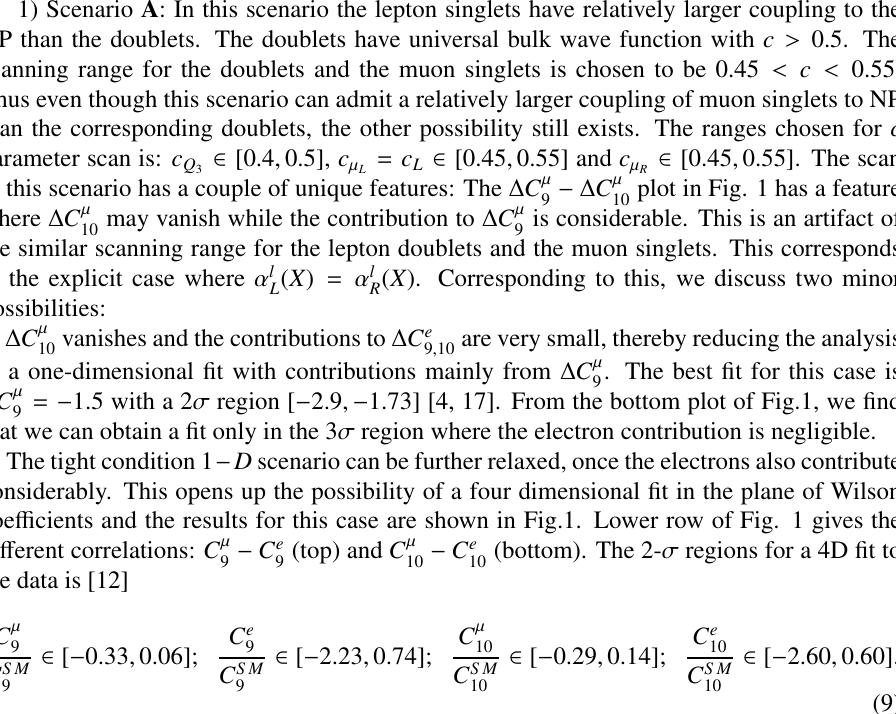
< if 1 . 4 < C µ 0 . 7 . We use M KK = 3 10 L − −